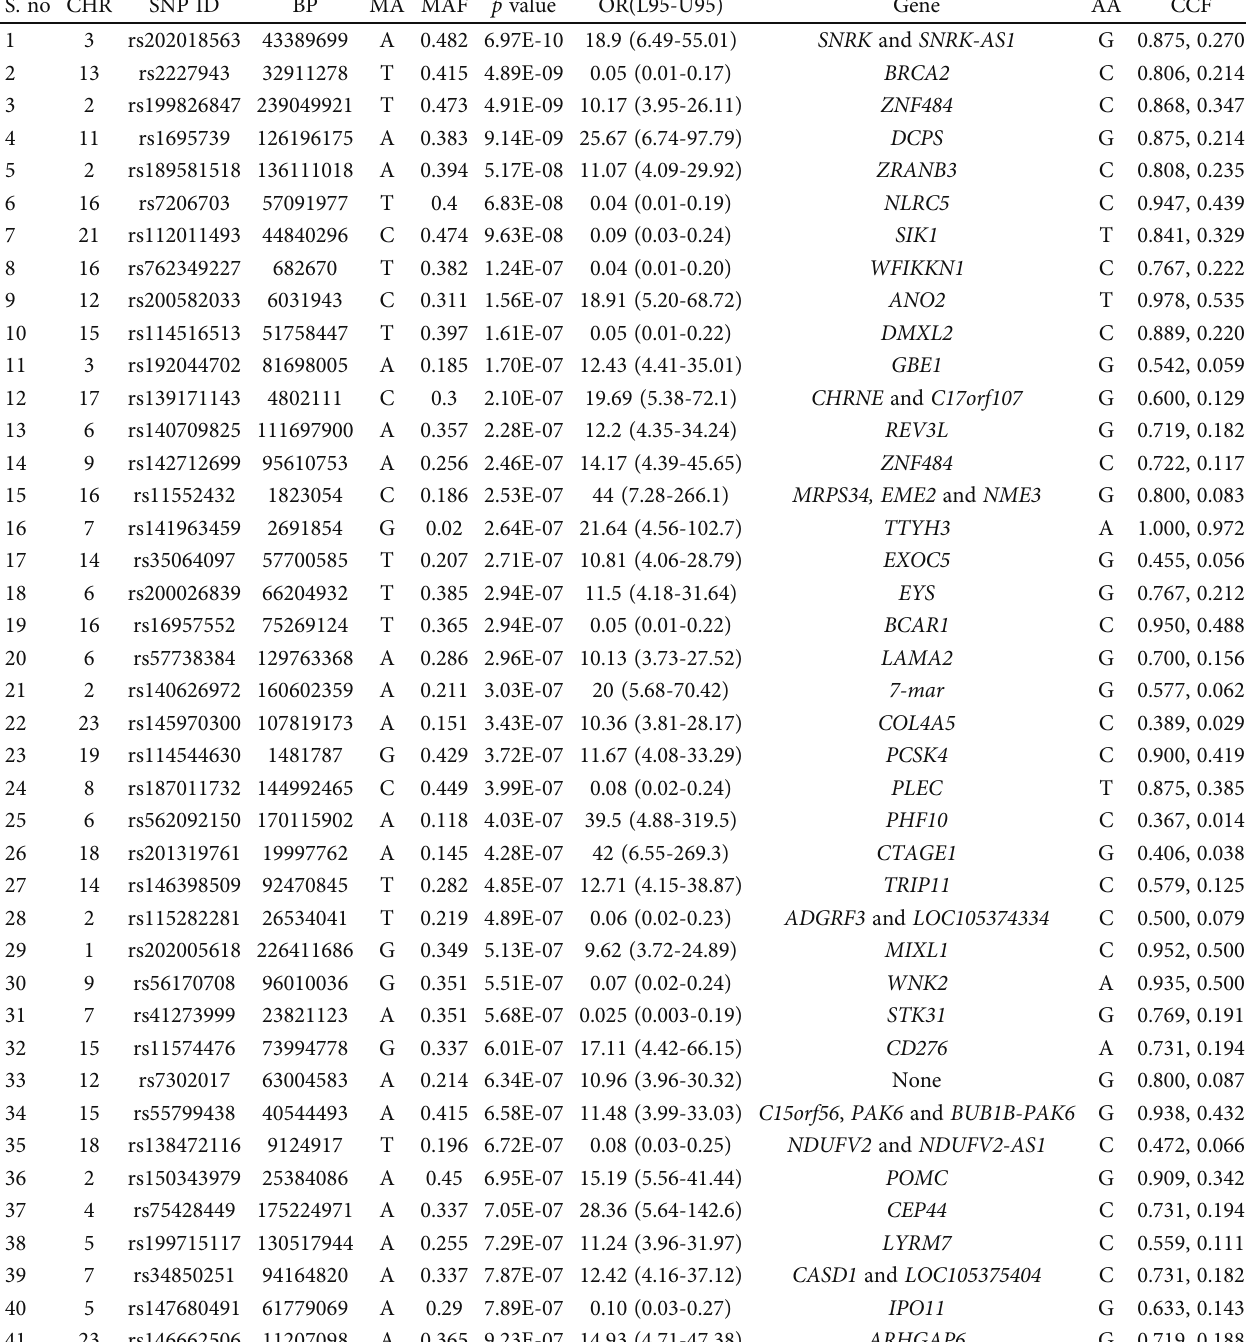
Table 2: The most signi fi cant SNPs associated with breast cancer in Saudi